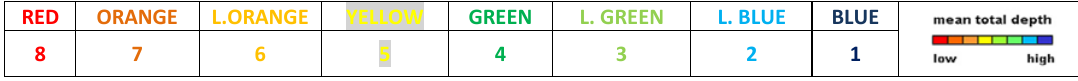
Table 2 Values assigned to color rankings of Integration in